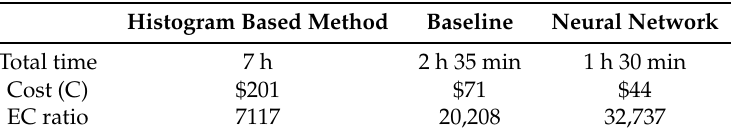
Table 7. Cost Effectiveness